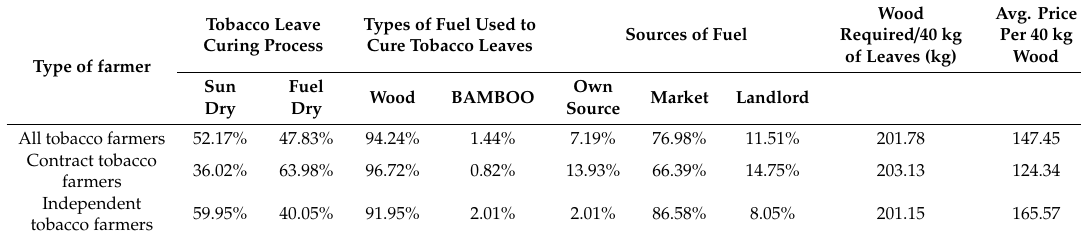
Table 11. Cost of processing / curing of tobacco leaf.